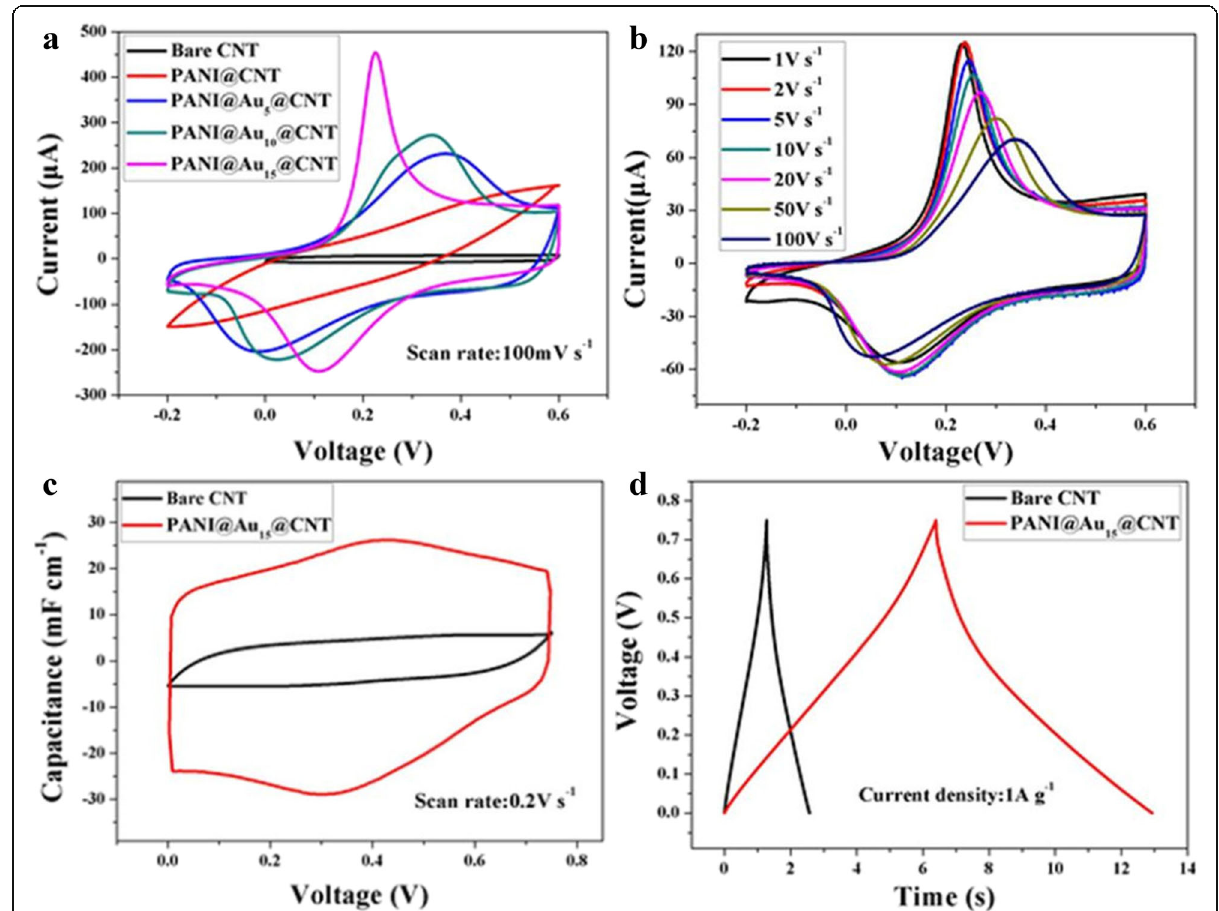
Fig. 4 a CV curves of bare CNT and PANI@Au x @CNT electrode materials at a scan rate of 100 mV s − 1 ; b CV curves of PANI@Au 15 @CNT at a scan rate of 1 – 100 V s − 1 ; c CV curves of supercapacitors based on the bare CNT and PANI@Au 15 @CNT at a scan rate of 200 mV s − 1 ; d GCD curves of supercapacitors based on the bare CNT and PANI@Au 15 @CNT electrodes at a current density of 1 A g − 1 . The CV curves obtained from different scan rates are normalized to 1 V s − 1 in